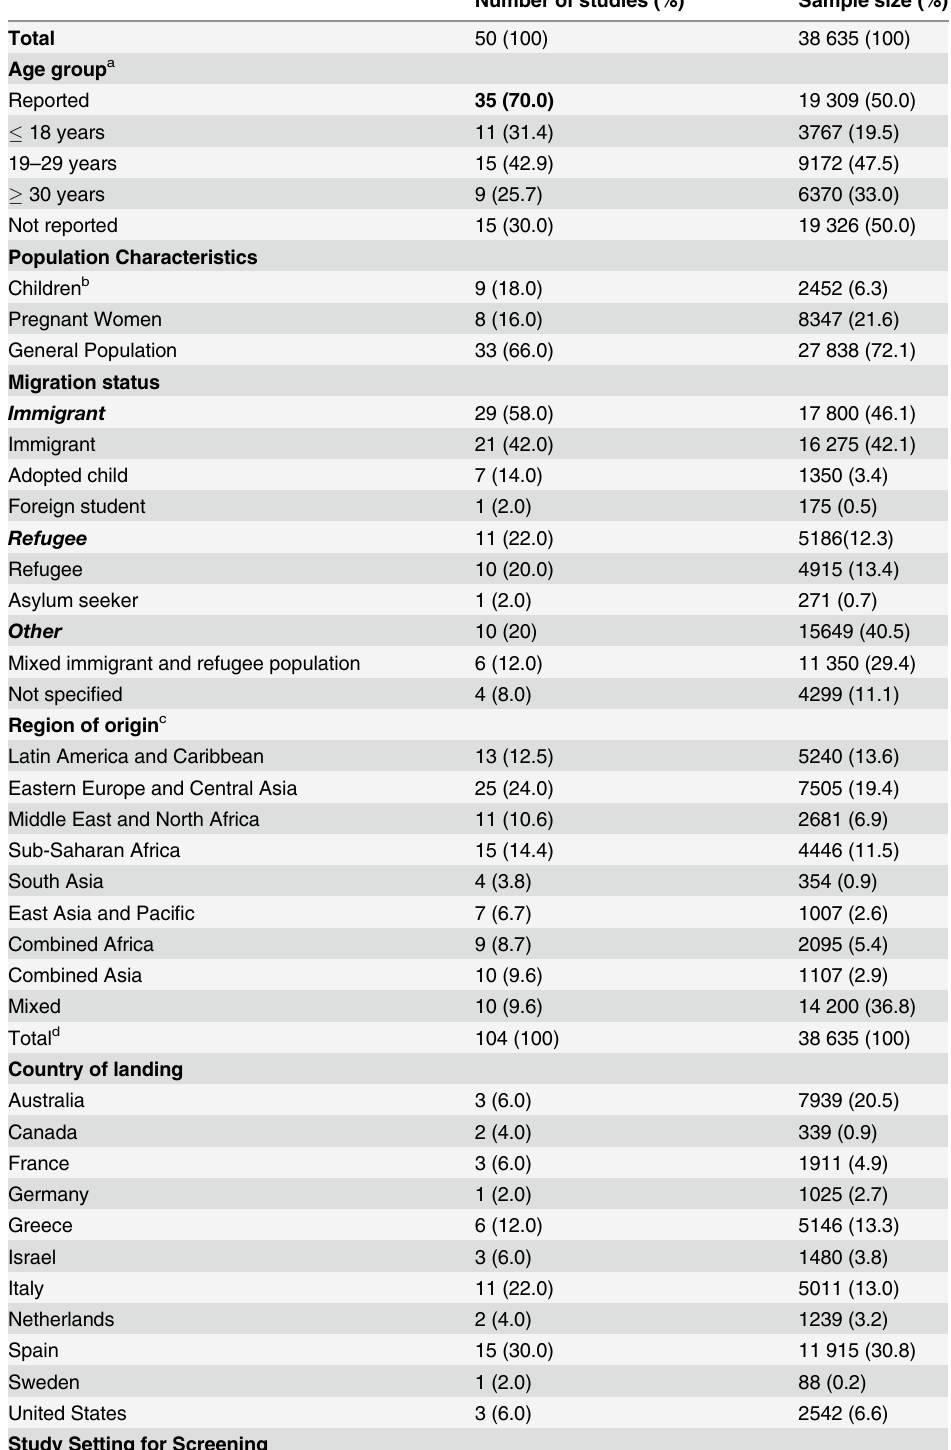
Table 1. Characteristics of included studies [70 – 119]. Abbreviations: EIA, enzyme immunoassay; CIA, chemiluminescent immunoassay; PCR, polymerase chain